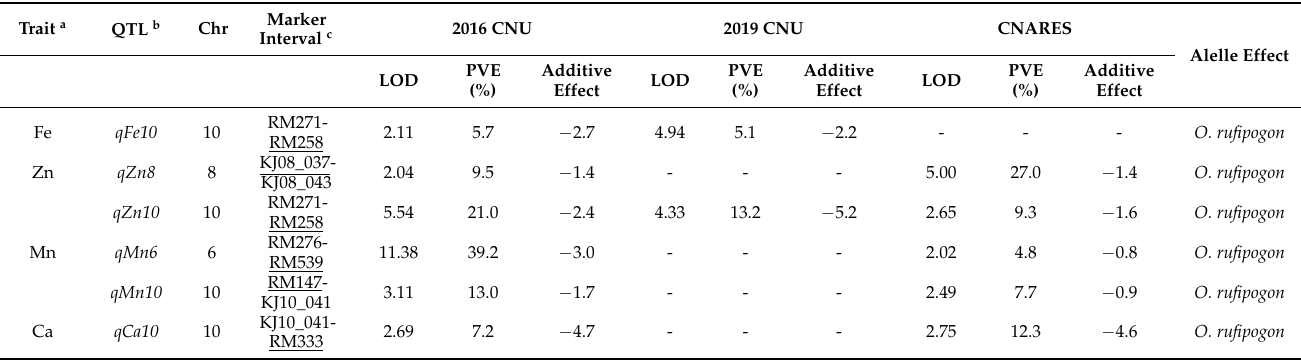
Table 2. QTLs for grain mineral element contents detected in 96 ILs.